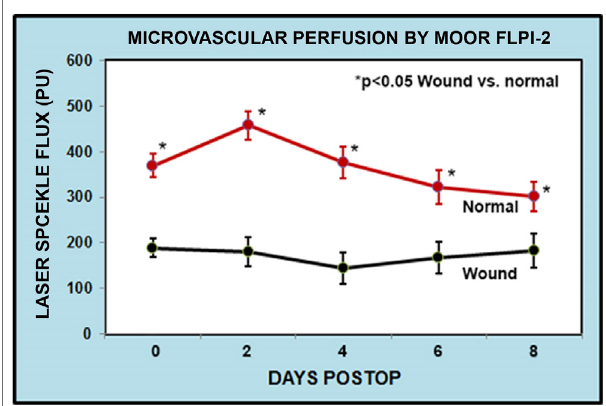
FIGURE2| Graphical representation of fl ux perfusion in rabbit back skin incisional wounds. Measured skin blood fl ow between the incisional wounds and normalskin usingMoorFLPI -2perfusion imager.Theischemiadifference was more signi fi cant at the early days which gradually decreased after 6 – 8 days. The FLPI-2 measurement is recorded as fl ux reading. The data were obtained from 8 to 10 different ROI (region of interest) sites as shown in Figure 1